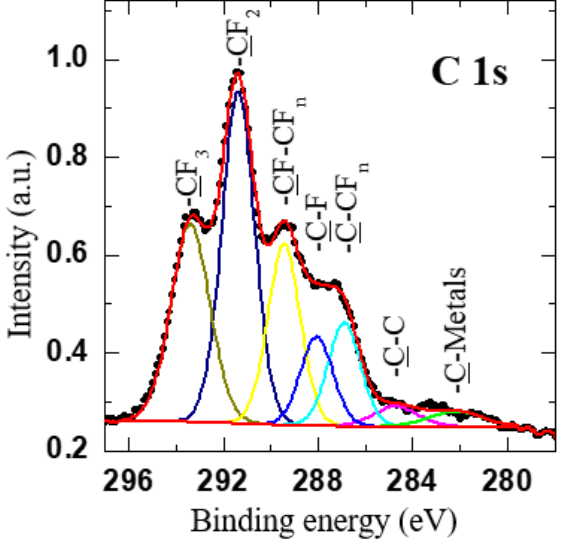
Figure 7. XPS high resolution spectra of C 1s representing an rf-sputtered Teflon ® coating on ns-Al (Tef/ns-Al).